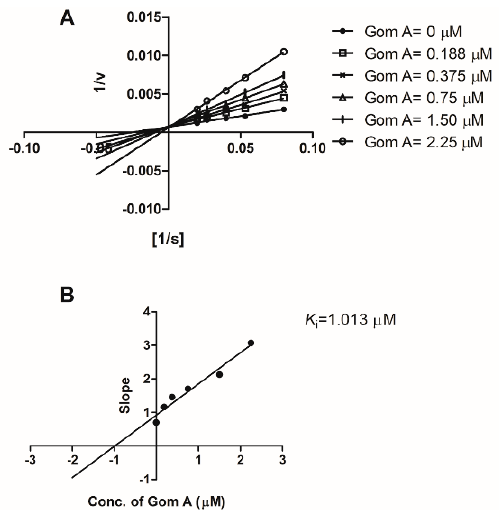
Figure 2. Lineweaver-Burk plot of Gom A on human liver CYP3A activity ( A ) and secondary plot of the slope taken from Lineweaver-Burk plot versus Gom A concentration ( B ). HLMs (0.5 mg protein/mL), different concentrations of Tes (12.5, 18.75, 25, 37.5 µM) and Gom A (0.375, 0.75, 1.5, 3 µM) were used. Each data point represents the mean of triplicate determinations.